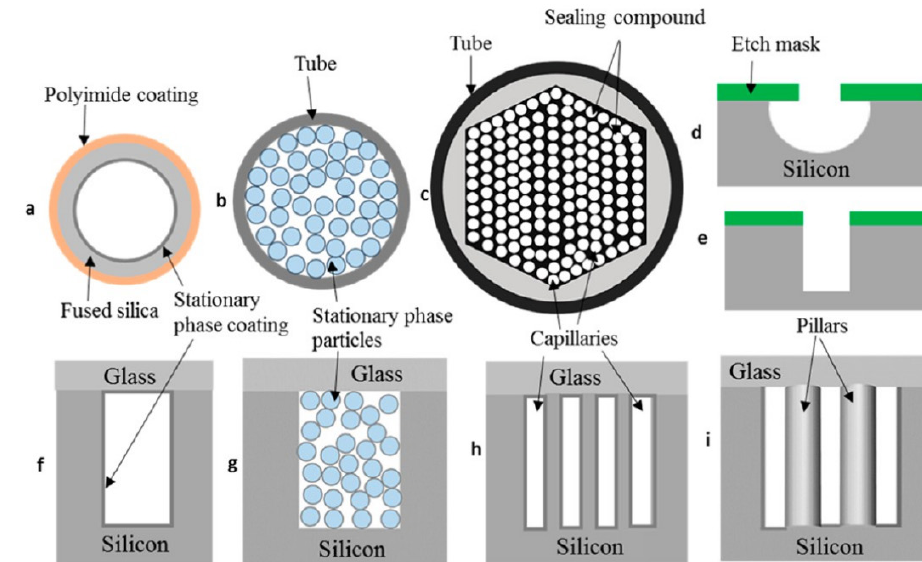
Figure 1: Cross-sectional view of different conventional GC column and MEMs